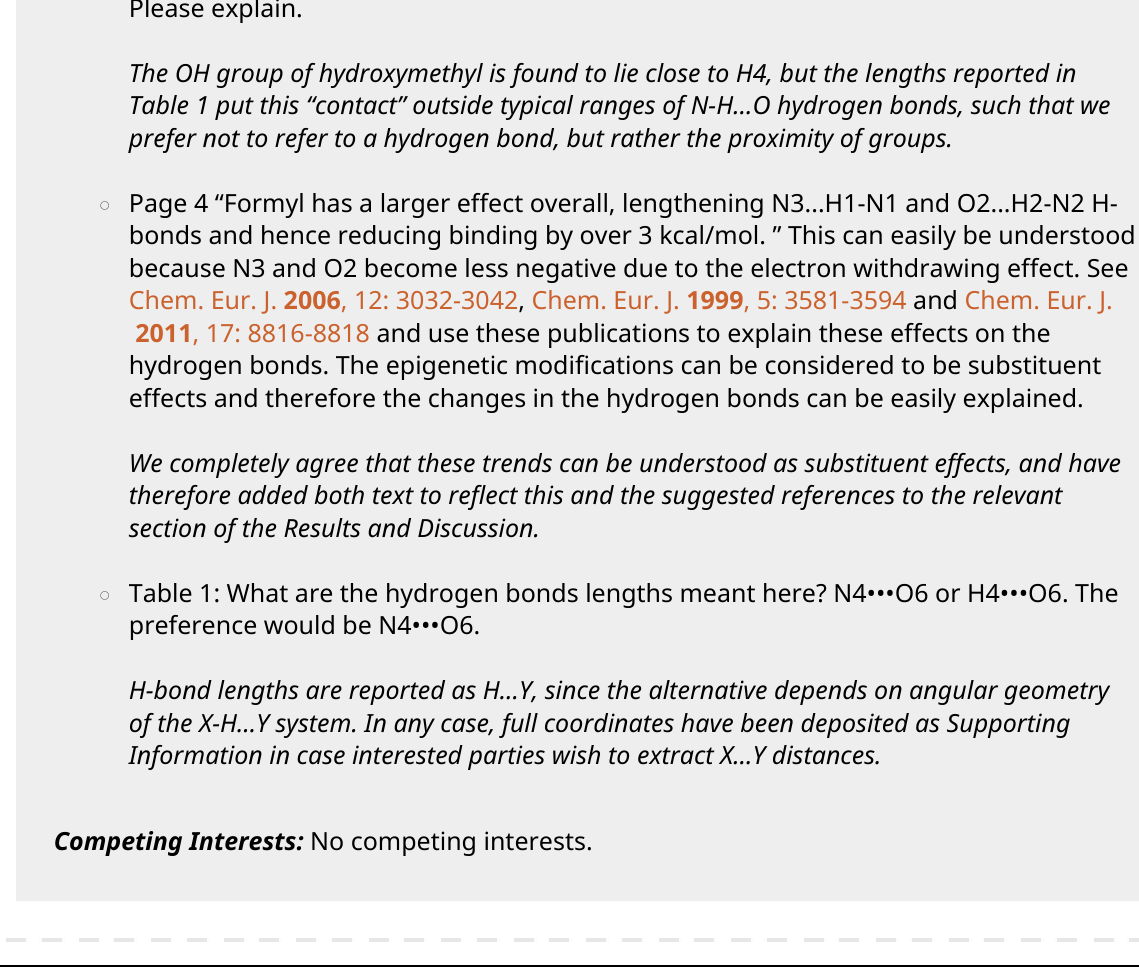
Legend of Figure 1: Please include the numbering, so that non-experts can follow the rest of the